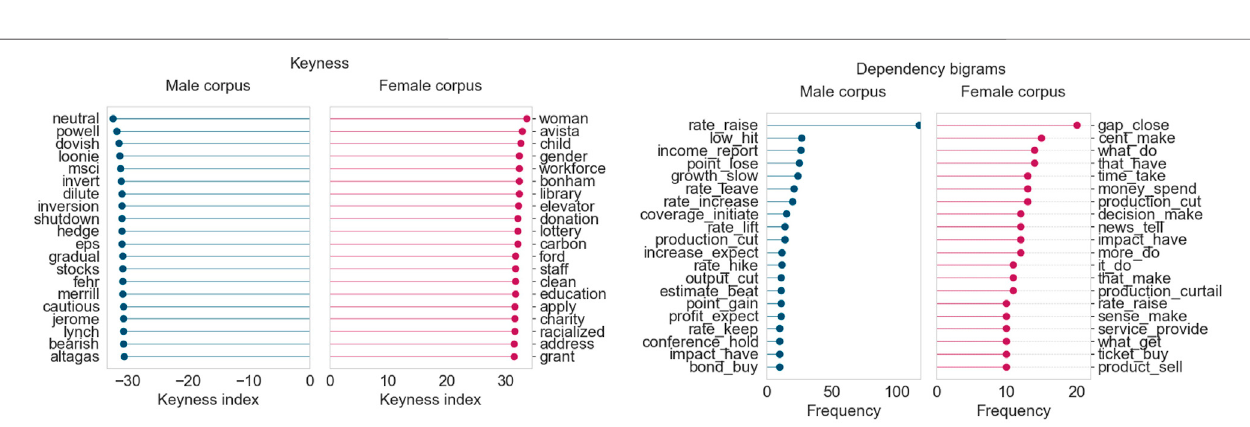
FIGURE 8 | Corpus analysis results for top 200 articles from “ Business ” (December